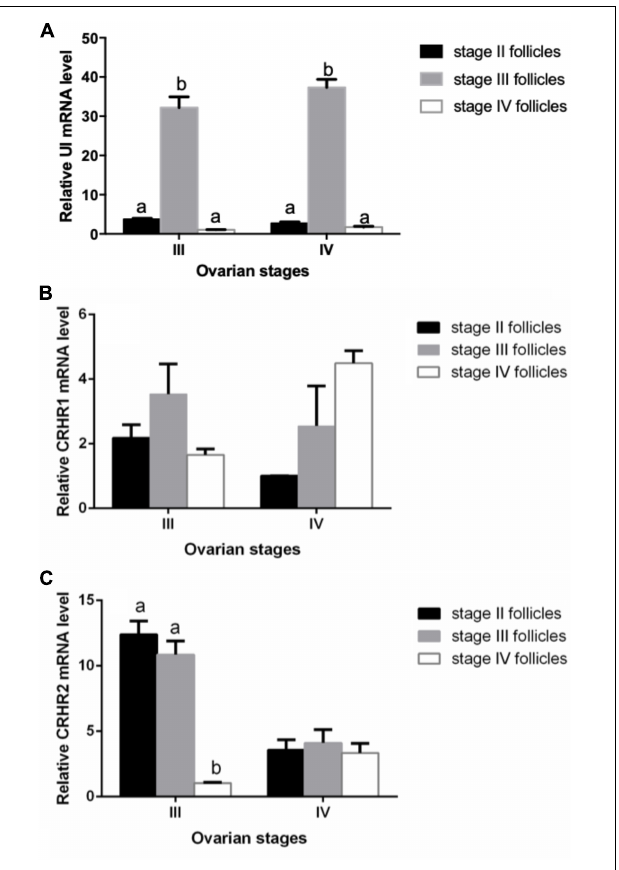
FIGURE 3 | Stage-dependent expression of UI (A) , CRHR1 (B) , and CRHR2 (C) at the follicles in Japanese flounder. Follicles of the different stages were isolated from Japanese flounder and RNA isolated from each stage for RT-PCR analysis. The expression level was normalized to β -actin. Each data point represents the mean ± SEM of three to four replicates. Significant differences among stage of ovarian development are indicated by different letters ( P <